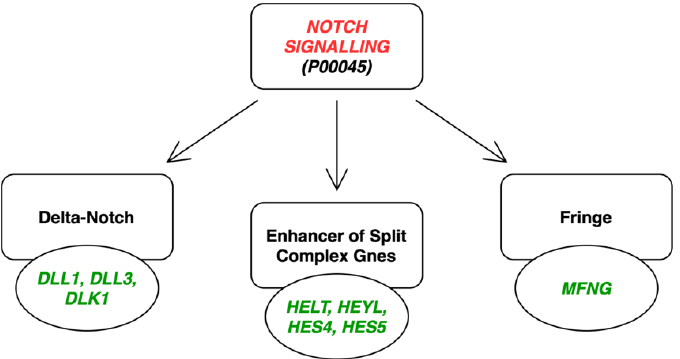
Figure 10. Upregulated effectors of NOTCH and downstream fringe signaling. Pathway analysis completed with PANTHER. GO: P00045.